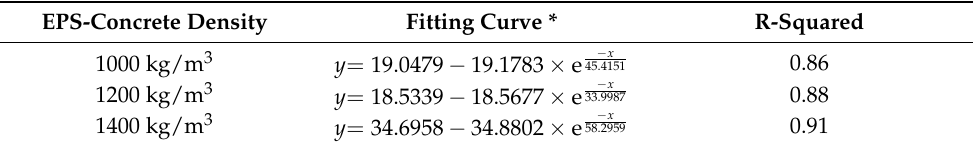
Table 3. Fitting curve of paste strength on EPS